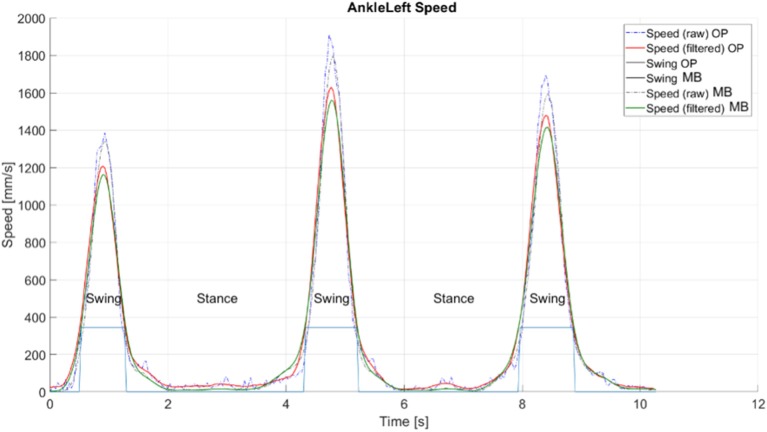
Extraction of gait phases from the trajectories of ankle nodes' velocity, explanatory example taken from a straight gait test. OP, OpenPose-based system; MB, marker-based optical system.